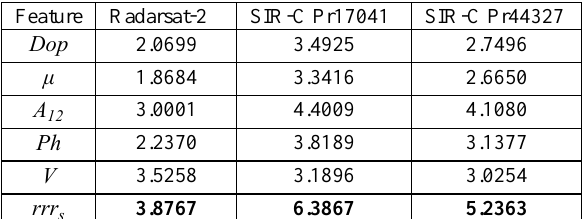
Table 3. The NDs between oil slicks and water of features in three SAR images.